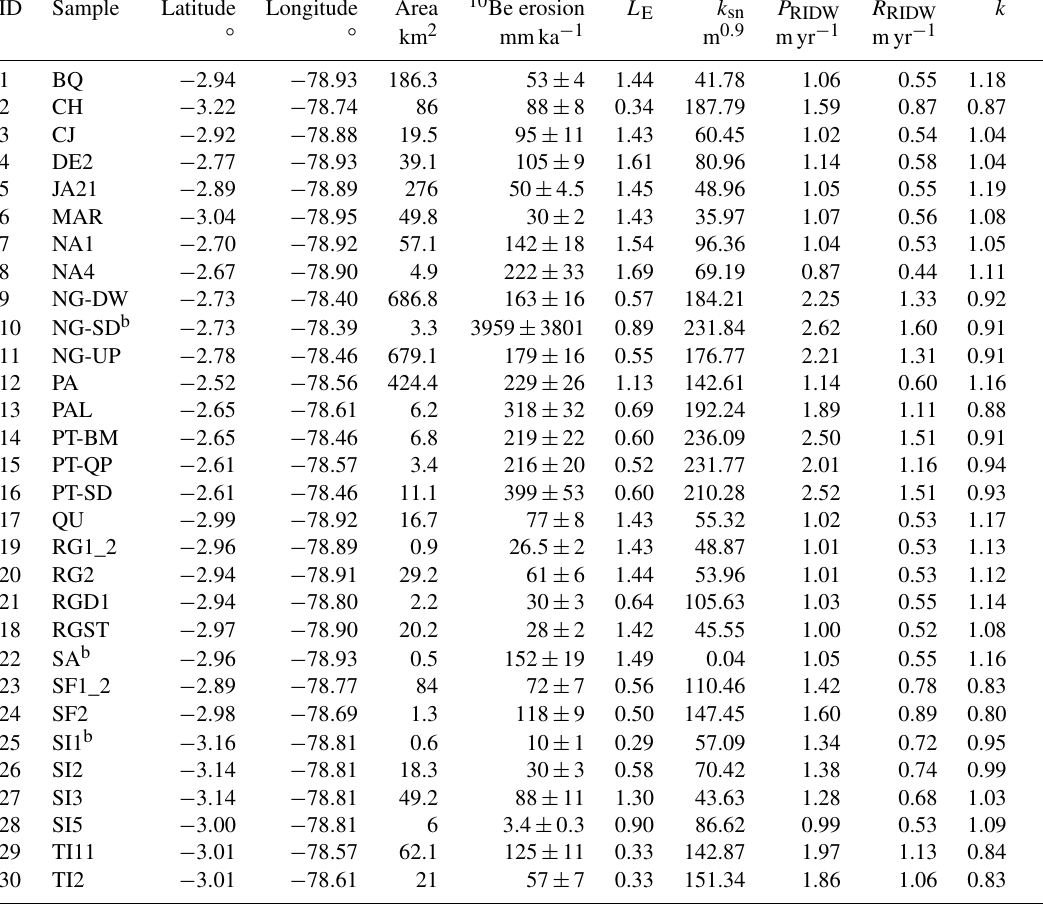
Table 2. Characteristics of the sub-catchments studied in this paper. IDs correspond to the numbers indicated in Fig. 1. The 10 Be cosmogenic nuclide erosion rates were derived from Vanacker et al. (2015) a . Coordinates are given in decimal degrees in the WGS84 datum, L E is the average lithological index for the catchment, k sn is the normalized catchment average steepness, P RIDW and R RIDW are respectively the downscaled catchment average precipitation and runoff, and k is the optimized discharge variability coefficient (see Eq.